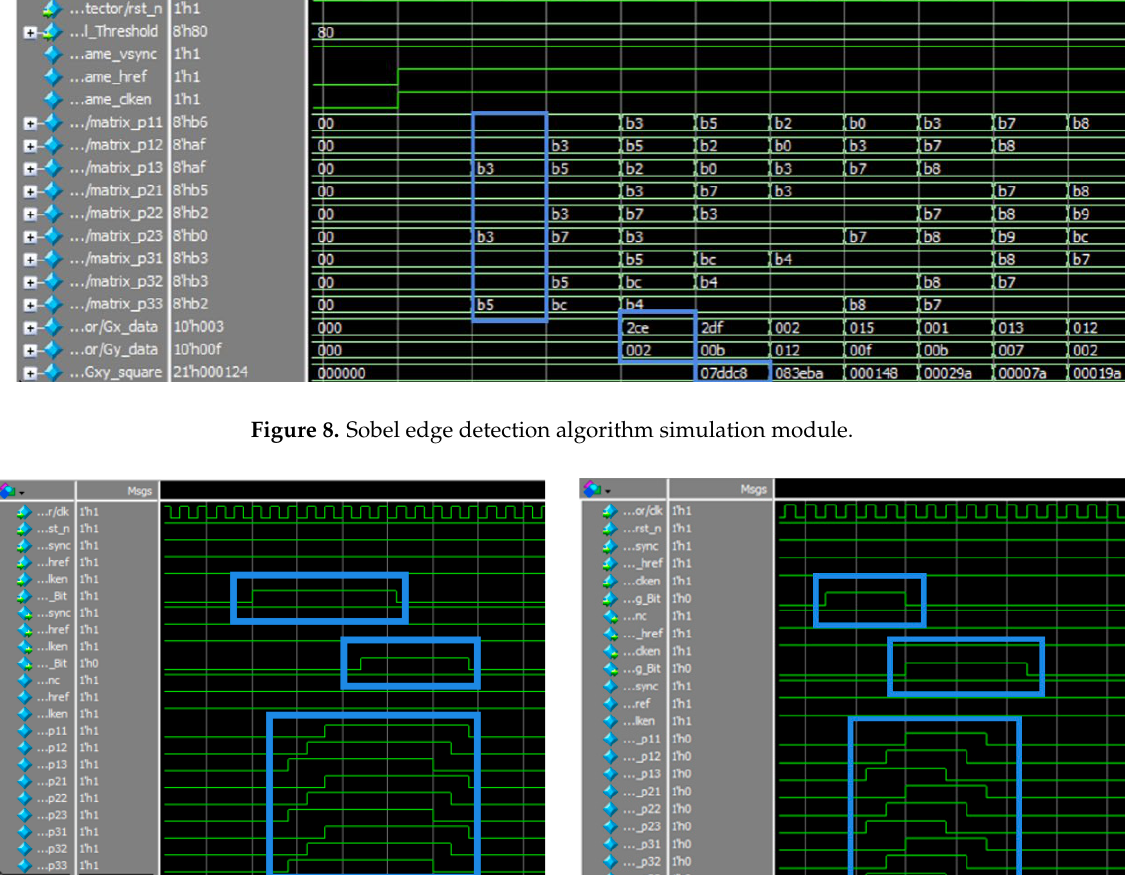
Figure 7. Median filtering algorithm simulation module.